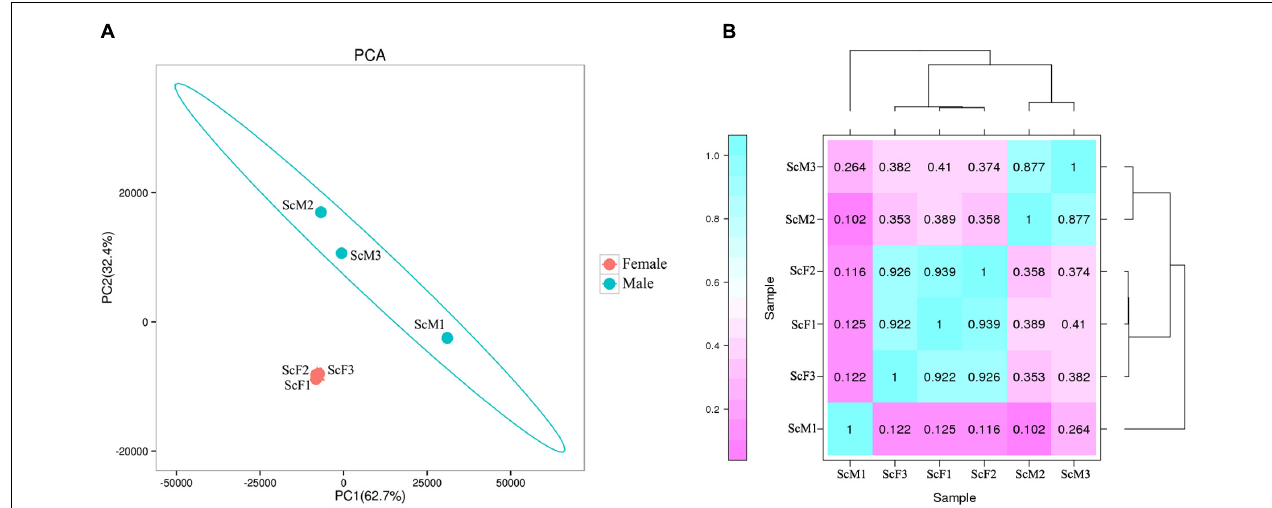
FIGURE 1 | Expression pattern analysis of gonad samples in S. constricta. (A) Principal components analysis (PCA) showed the strong clustering associated with sex except for ScM1. (B) Sample correlation heatmap plot revealed exact sex identification except for ScM1 . Dark green represents strong correlation and dark pink represents weak correlation, and the number in each column and row correspond to the correlation coefficient of one sample with the other five samples including itself.